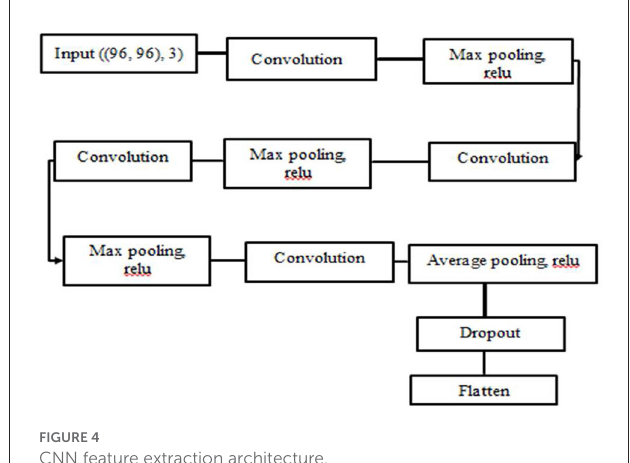
FIGURE4 CNN feature extraction